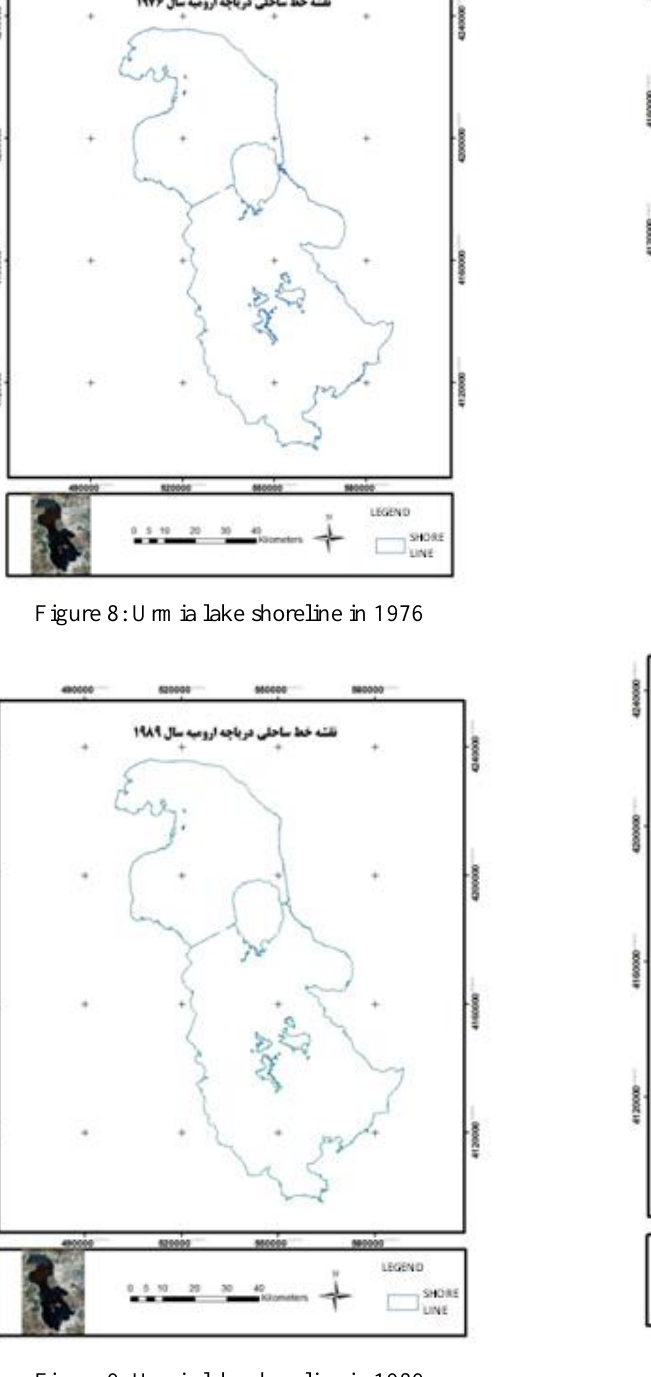
Figure 11: Urmia lake shoreline in